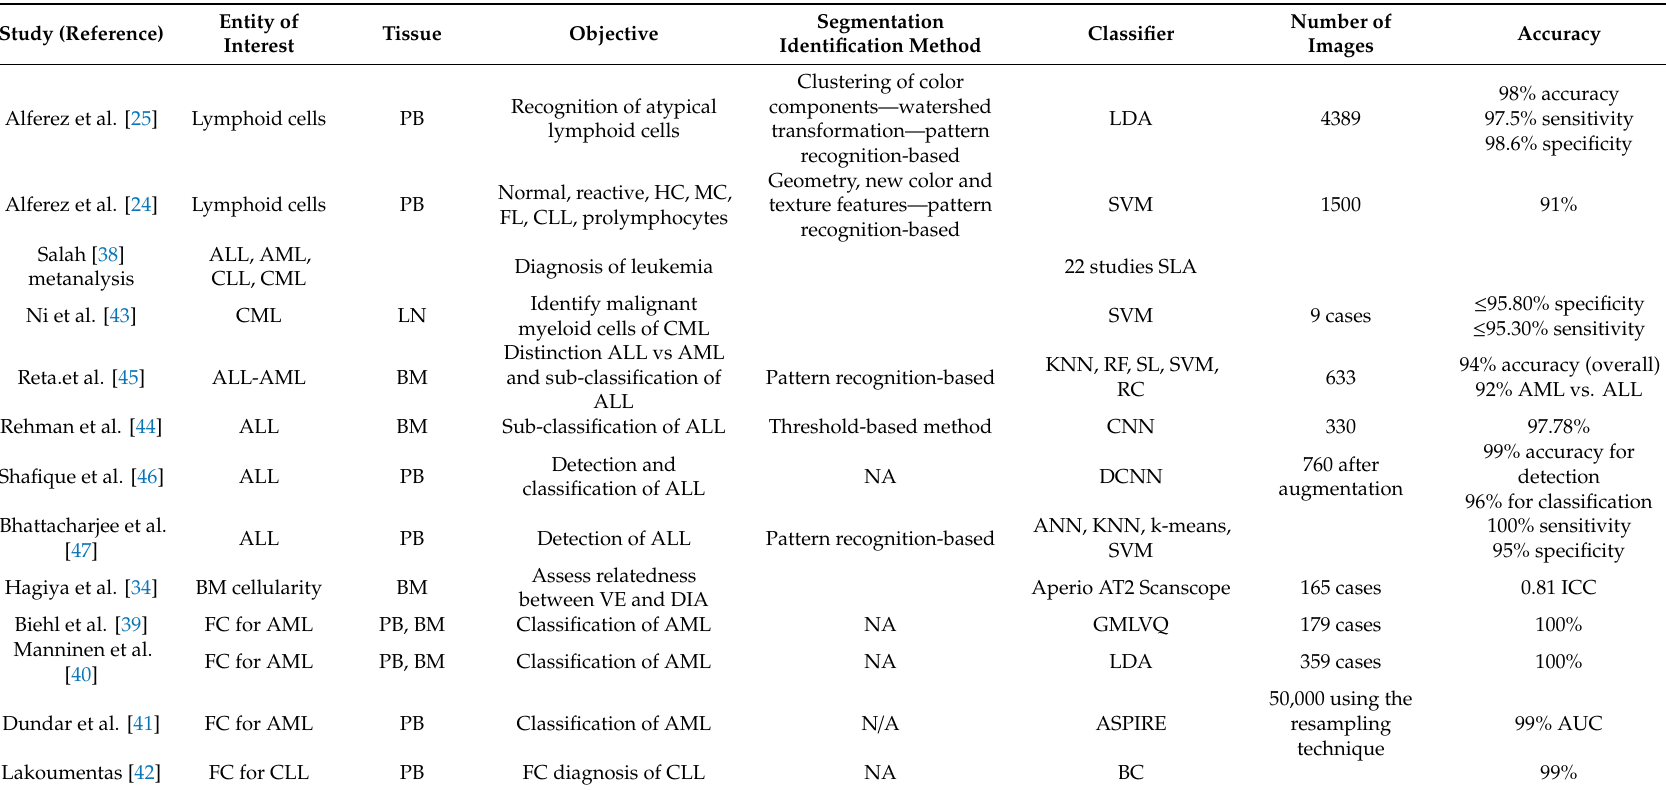
Table 1. Studies utilizing machine learning (ML) for hematologic malignancies. PB, peripheral blood; LDA, linear discriminant analysis; HC, hairy cells; MC, mantle cells; FL, follicular lymphoma; CLL, chronic lymphocytic leukemia; SLA, supervised learning algorithms; SVM, support vector machine; BM, bone marrow; ALL, acute lymphocytic leukemia; AML, acute myelocytic leukemia; CML, chronic myeloid leukemia; KNN, K-nearest neighbor; RF, random forest; SL, simple logistic; RC, random committee; CNN, convolutional neural network; DCNN, deep convolutional neural network; ANN, artificial neural network; VE, visual estimates; DIA, digital image analysis; GMLVQ, generalized matrix relevance learning vector quantization; LDA, linear discriminant analysis; BC, Bayesian clustering;